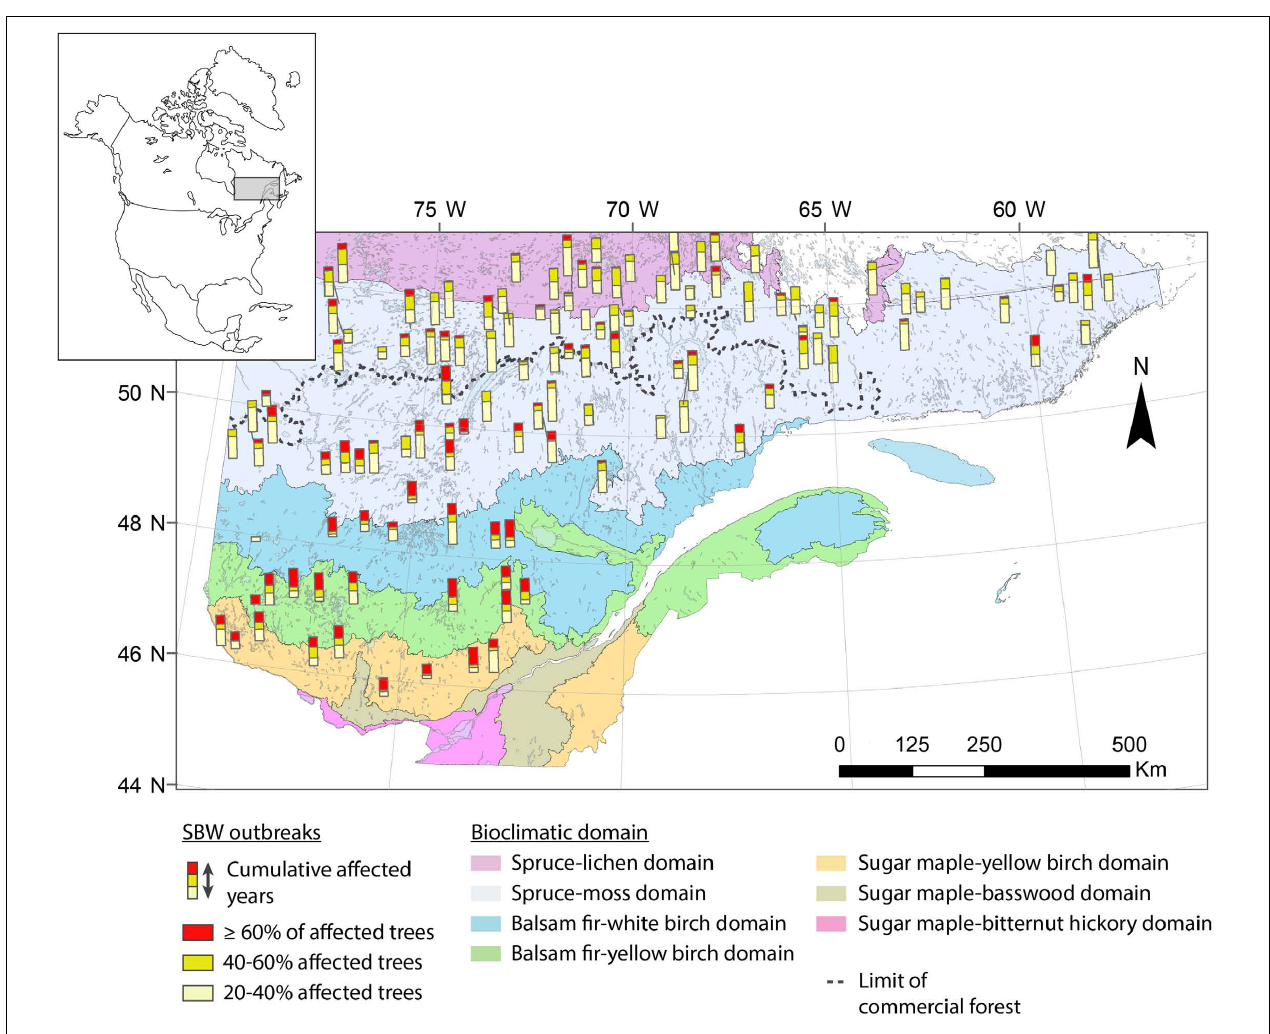
FIGURE 5 | Cumulative years of infestation in the study area by category of